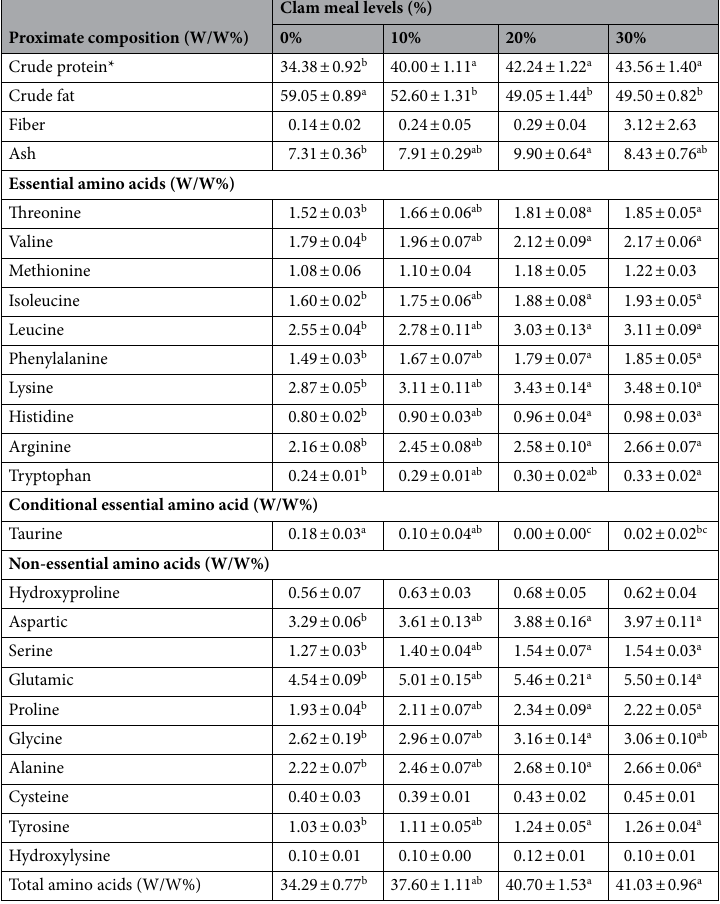
Table 5. Whole-body proximate and amino acid compositions. Analyzed by the Experiment Station Chemical Laboratories (ESCL), University of Missouri, Columbia, MO 65211. Results are expressed on an "as is" basis unless otherwise indicated. W/W% = grams per 100 g of sample. Crude protein* = %N × 6.25. a,b,c Mean values within a row with unlike superscript letters were significantly different ( P <